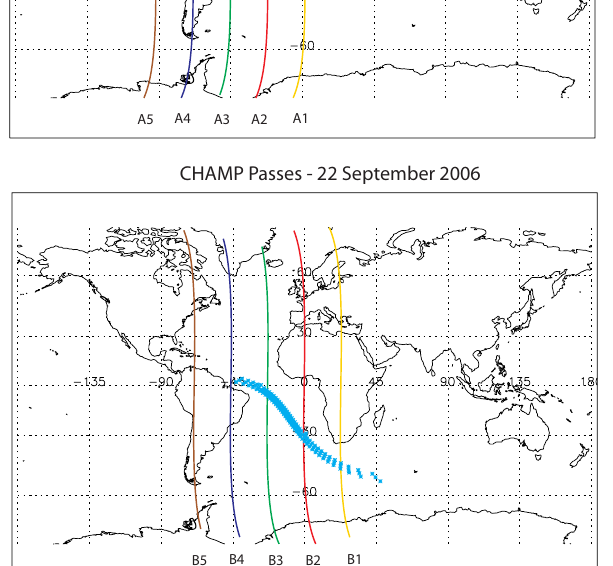
Fig. 1. World map projection for the 2 eclipses, showing the path of the umbral/antumbral shadow (cyan) and the CHAMP passes con- sidered. The time for each pass (accordingly labelled) is indicated in Table